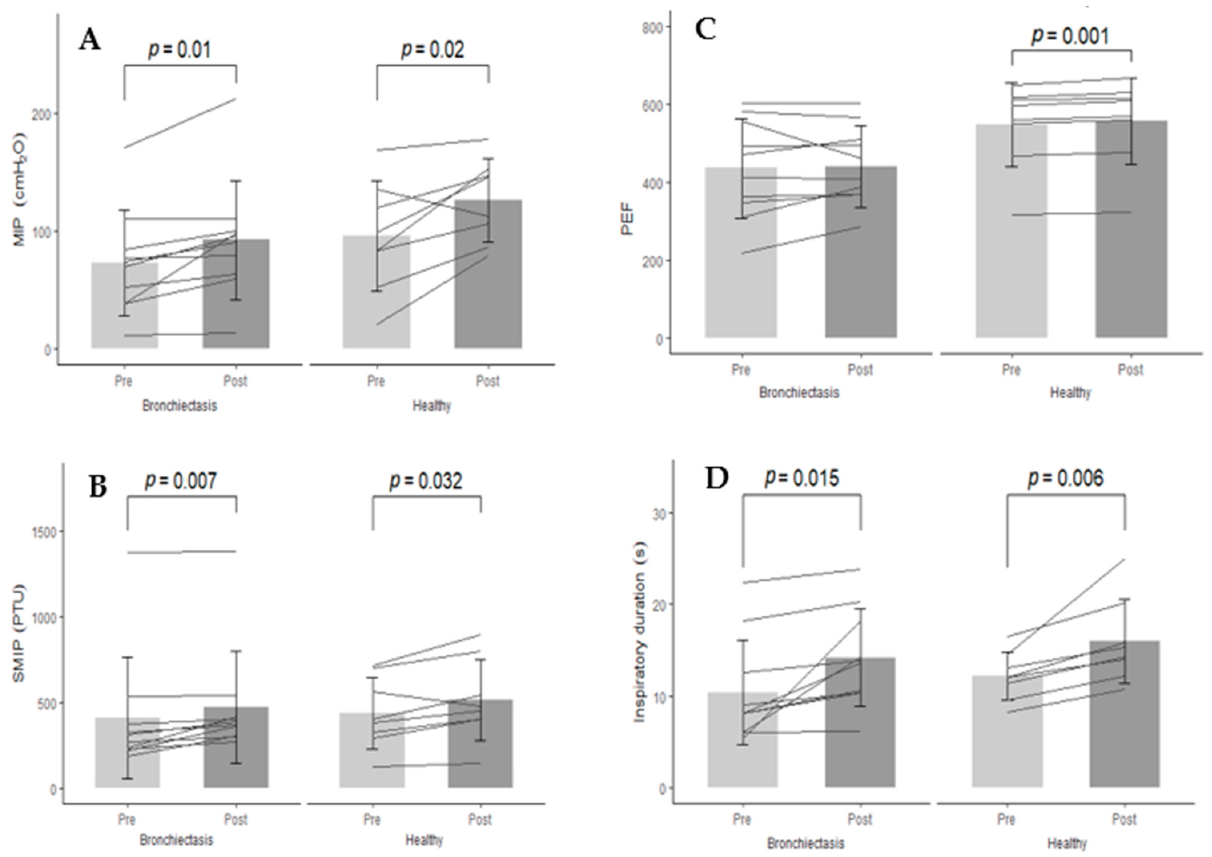
Figure 1. Changes in ( A ) maximal inspiratory pressure (MIP); ( B ) sustained maximal inspiratory pressure (SMIP); ( C ) peak expiratory flow (PEF) and ( D ) inspiratory duration over the eight weeks of an inspiratory muscle training intervention in adults with bronchiectasis and healthy controls. Grey columns represent the mean group response with standard deviation bars. Overlaid lines represent individual responses. Table 3. Self-determination measures after eight weeks of inspiratory muscle